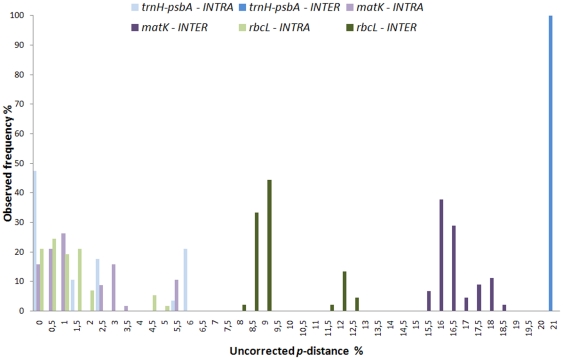
Observed frequency of uncorrected intra- and intergeneric p-distance.The frequency of the uncorrected p-distance was analyzed to visualize the “barcoding gap”. Frequency was logged on a scale from 0 to 20% distance, indicating that trnH-psbA is out performing with an average inter-specific p-distance of more than 20%. Inter-generic p-distance shown in darker color and intra-generic p-distance lighter color, blue for trnH-psbA spacer, violet for matK and green for rbcL, respectively.